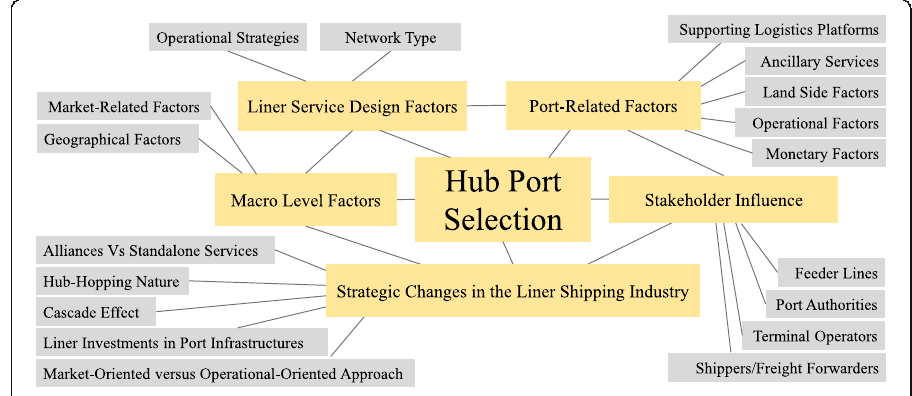
Fig. 5 Contextualized Framework of Factors Influencing Hub Port